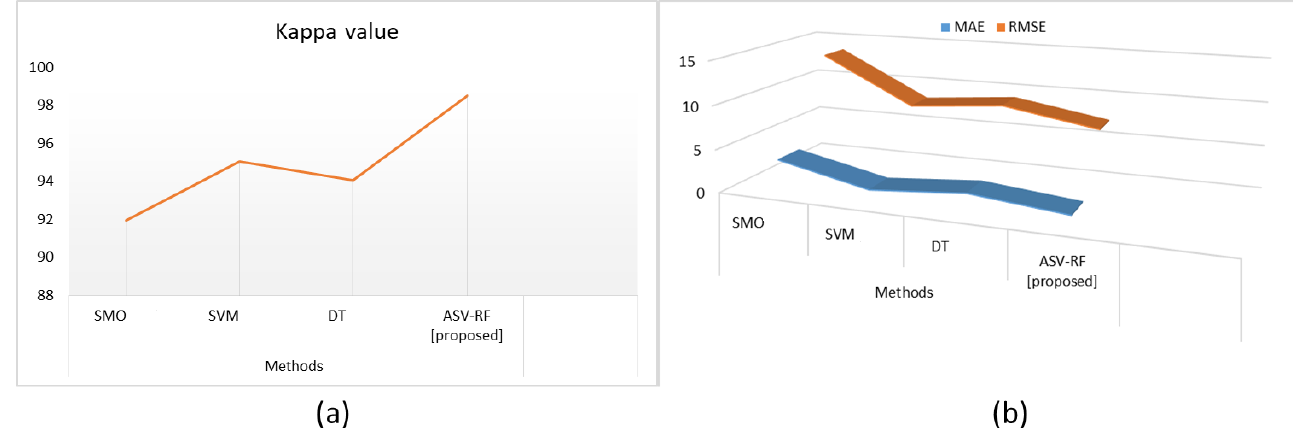
Figure 6. Results of Kappa ( a ), MAE, and RMSE metrics ( b ).